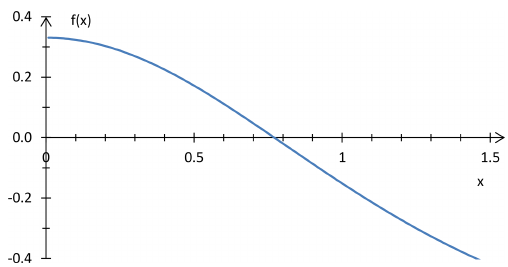
Figure C1. Function f (x) (defined in Eq. C9), with a = 1 . 1, C 1 = 0 . 12, C 2 = 3 . 4, and C 3 = 9 .